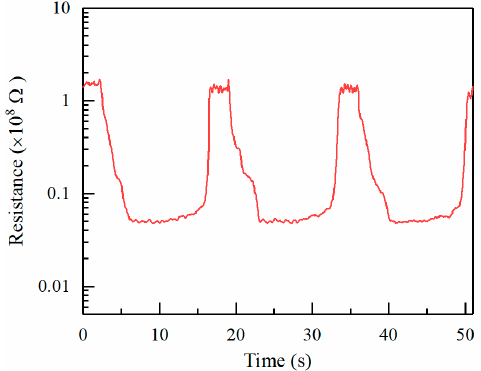
Figure 8. Response of the gas sensor towards repeated exposures to the alcohol vapor. The deposition time for ZnO is 15 min. The concentration of alcohol is 150 ppm.